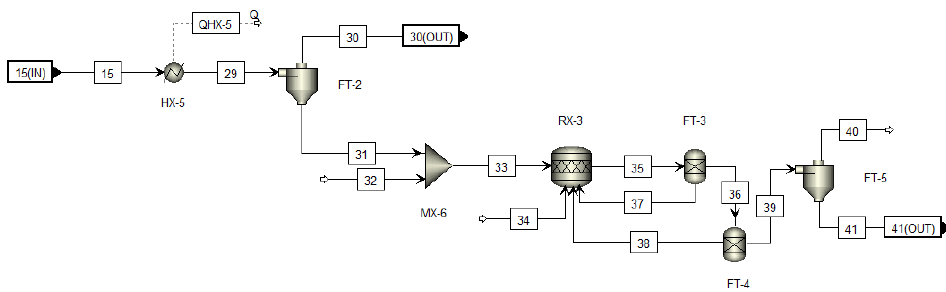
Figure 8. Hydrolysis stage flowsheet in topology 2.